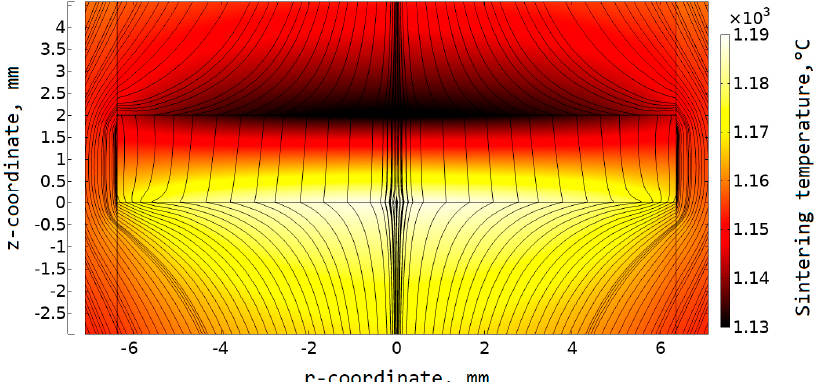
Figure 5. Normal current density lines in the sample and surrounding setup elements; the distribution of temperature field is presented by the 2D plot; the results are presented for p –type Si-Ge specimen sintered at 1150 °C.